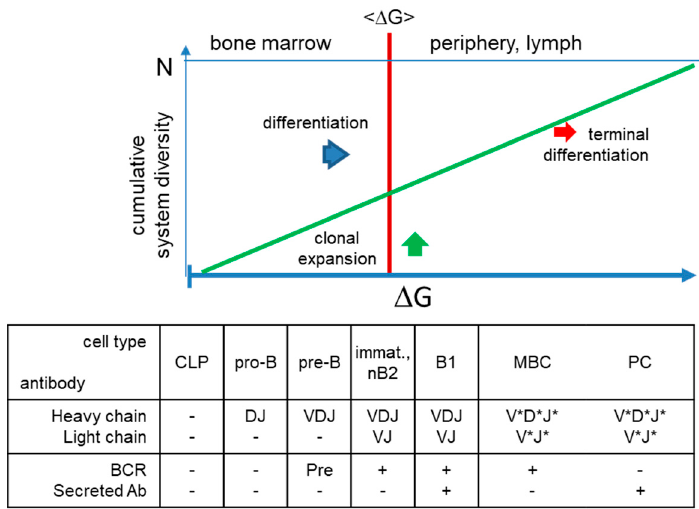
Figure 4. Generation of structural diversity in the humoral immune system. Beyond the bone marrow, multidirectional growth towards antigenic shapes generates diversity in the system, further enlarging that of the naïve repertoire. The energy of these interactions is adjusted for each antigen based on its immunological properties, thereby secreted antibodies can adjust the concentration of the target antigen in the host. *somatic hypermutations; CLP, common lymphoid progenitor; immat., immature; nB2, naive B2 cell; MBC, memory B cell; PC, plasma cell; BCR, B-cell receptor.